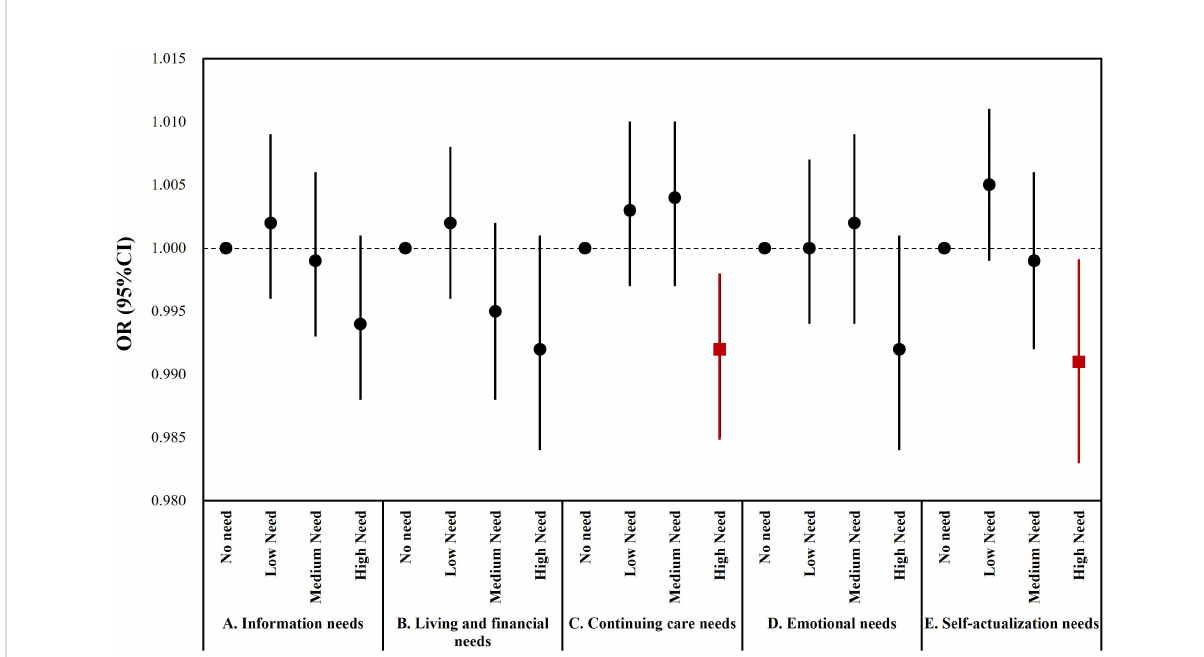
FIGURE 2 Results of multivariate ordered logistic analysis of the post-diagnosis time and participants ’ need level. *Red symbols represent p<0.05. The model was adjusted for age, sex, tumor status, and disease